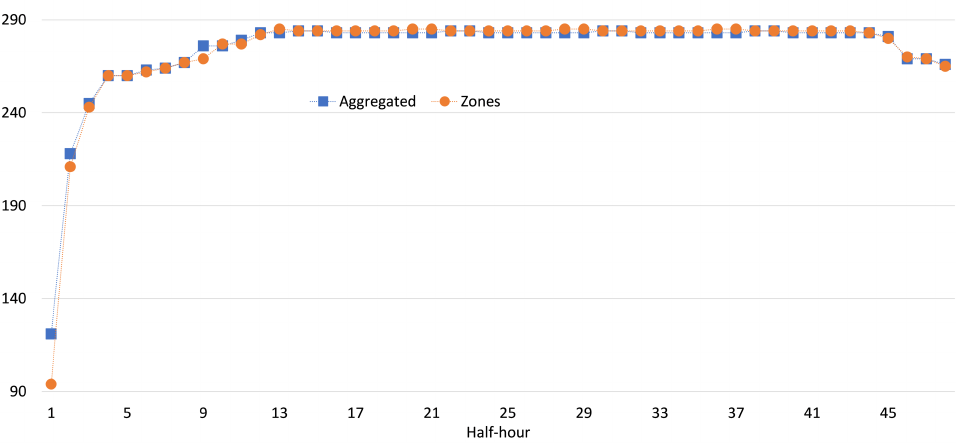
Figure 13. Total number of thermal units committed in Case 8 Trial 1.